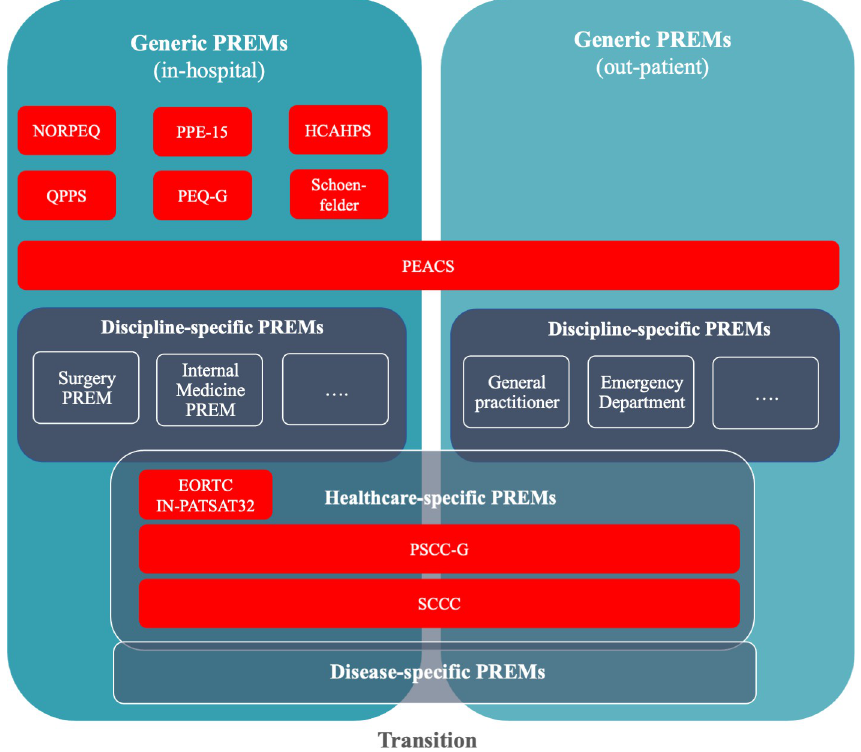
Fig 2. German language Patient-Reported Experience Measures (PREMs). Overview of German PREMs in their intended category of use.